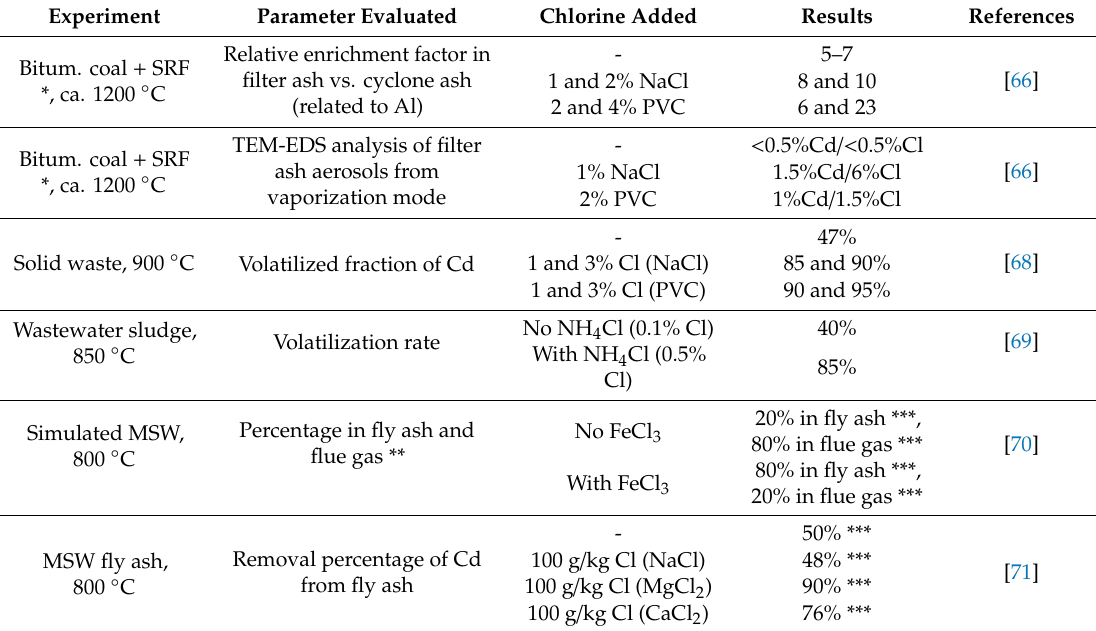
Table 4. E ff ect of Cl compounds on Cd